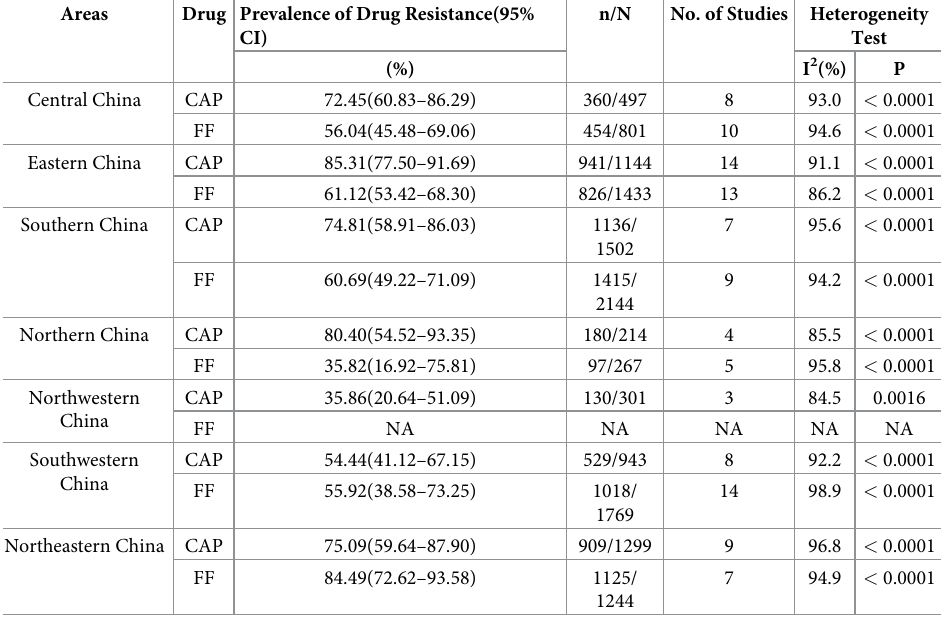
Table 2. The prevalence of the Chloramphenicol/Florfenicol resistance in the different regions. Areas